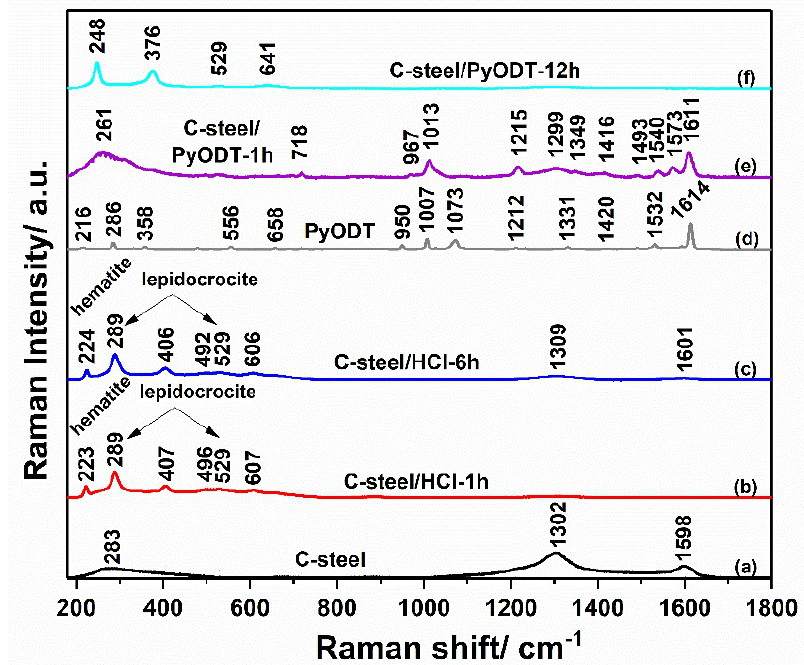
Figure 10. Raman spectra of the C-steel surface before ( a ) and after exposure to 1.0 M HCl solution for 1 h ( b ) and 6 h ( c ), of the PyODT powder ( d ), and the C-steel surface after 1 h ( e ) and 12 h ( f ) exposure to 5 mM PyODT-containing solution.